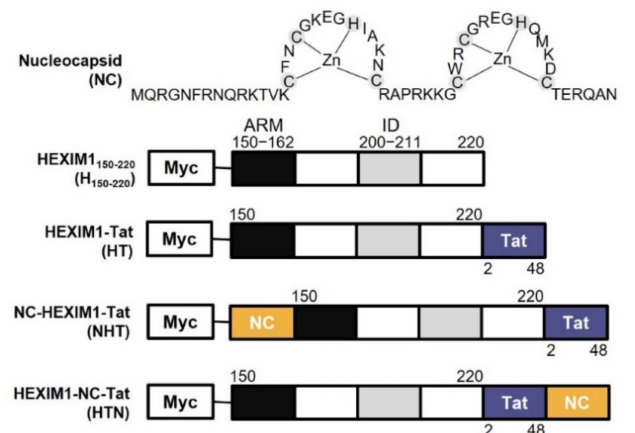
Figure 1. The scheme of HEXIM1 derived chimeric proteins. The structure of the NC zinc finger motifs and functional domains of HEXIM1 and Tat, namely ARM (black box, residues 150–162), which binds RNA, ID (gray box, residues 200–211), which inhibits CDK9 through a PYNT motif, and AD (blue box, residues 2–48), which binds to P-TEFb. NC (yellow box, residues 1–55) was inserted in front of or behind HT. All chimeric proteins were tagged with Myc at the N-terminus. The size of each box does not reflect the actual size of the domain. NC, nucleocapsid; ARM, arginine-rich motif; ID, inhibitory domain; AD, transactivation domain; P-TEFb, positive transcription elongation factor b; HT,